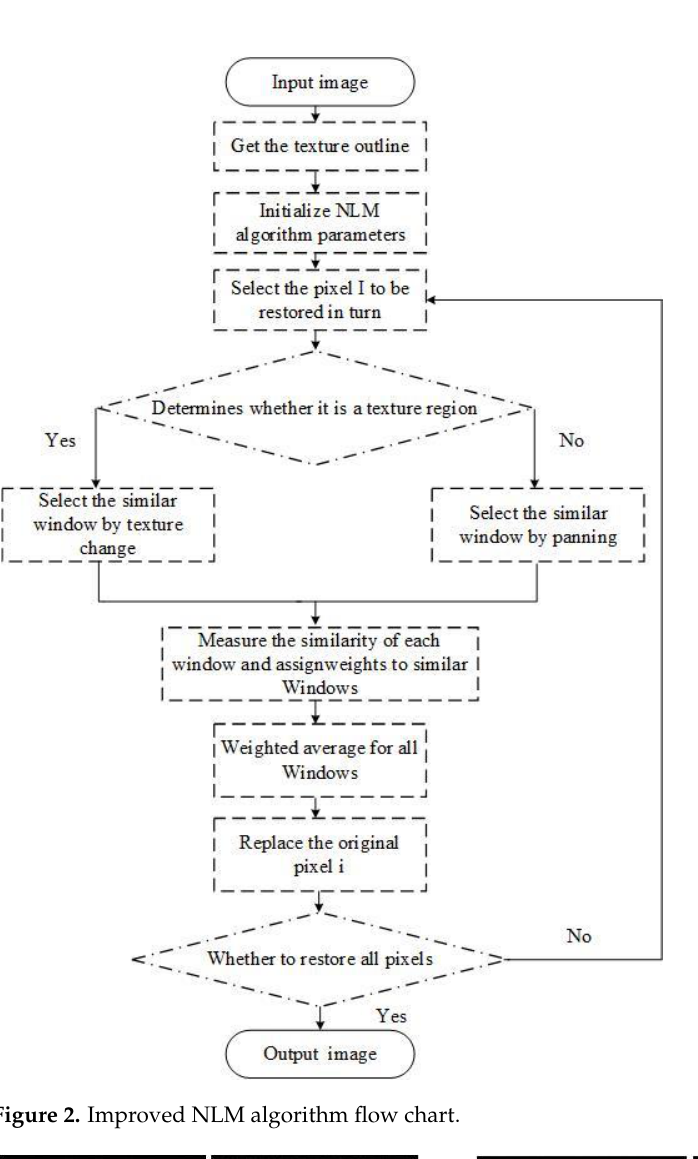
Figure 2. Improved NLM algorithm flow chart.